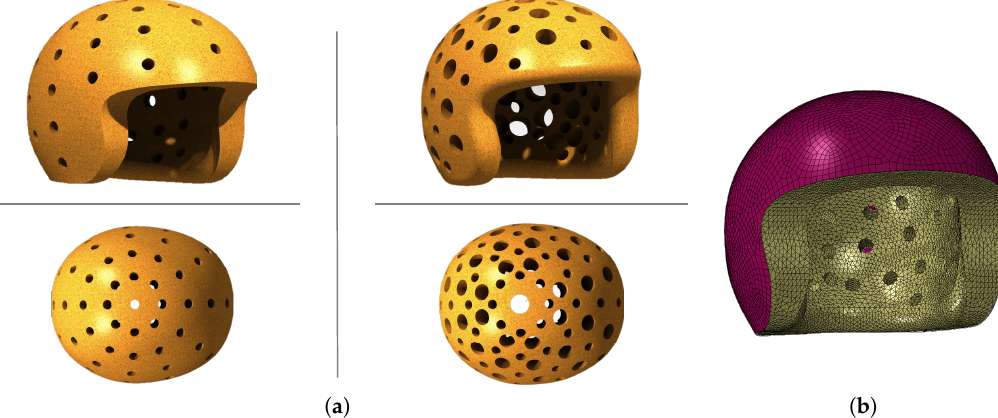
Figure 14. Lighter holed versions of the 40 mm thick cork liner: ( a ) Left—render of the 15 mm diameter-holed version; Right—render of the 25 mm diameter-holed version. ( b ) FE helmet model of the 15 mm diameter-holed